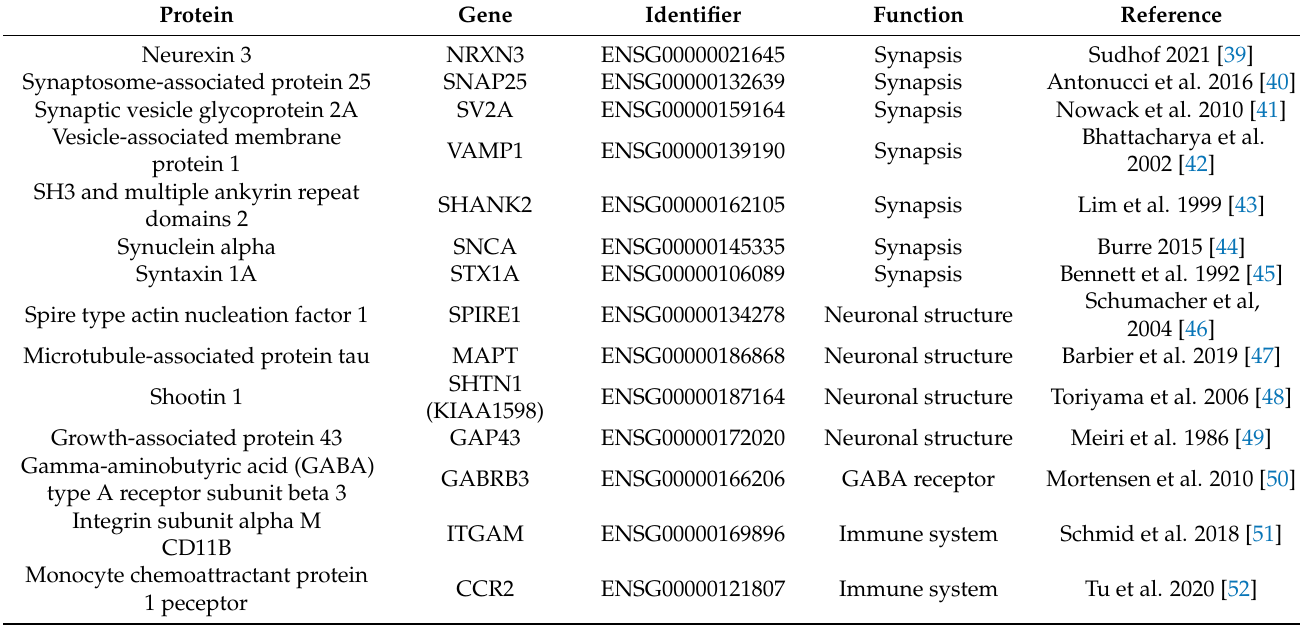
Table 1. Neuronal and monocytic genes and their functions.